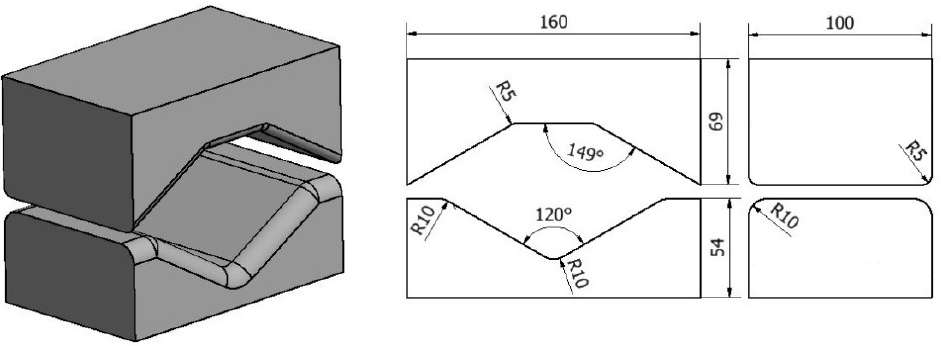
Figure 3. Shape and dimensions of flat dies used for AZ91 magnesium alloy forging.